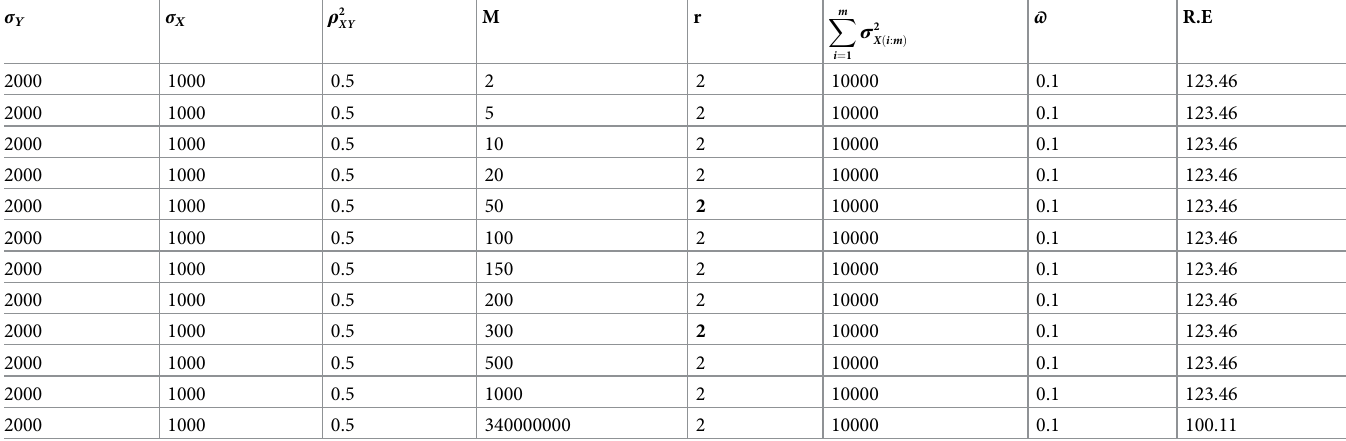
in comparison to ^ μ ; impact of increase in m, for larger variation in the study variable, and the auxiliary variable. NGO : Disclosures IRSS